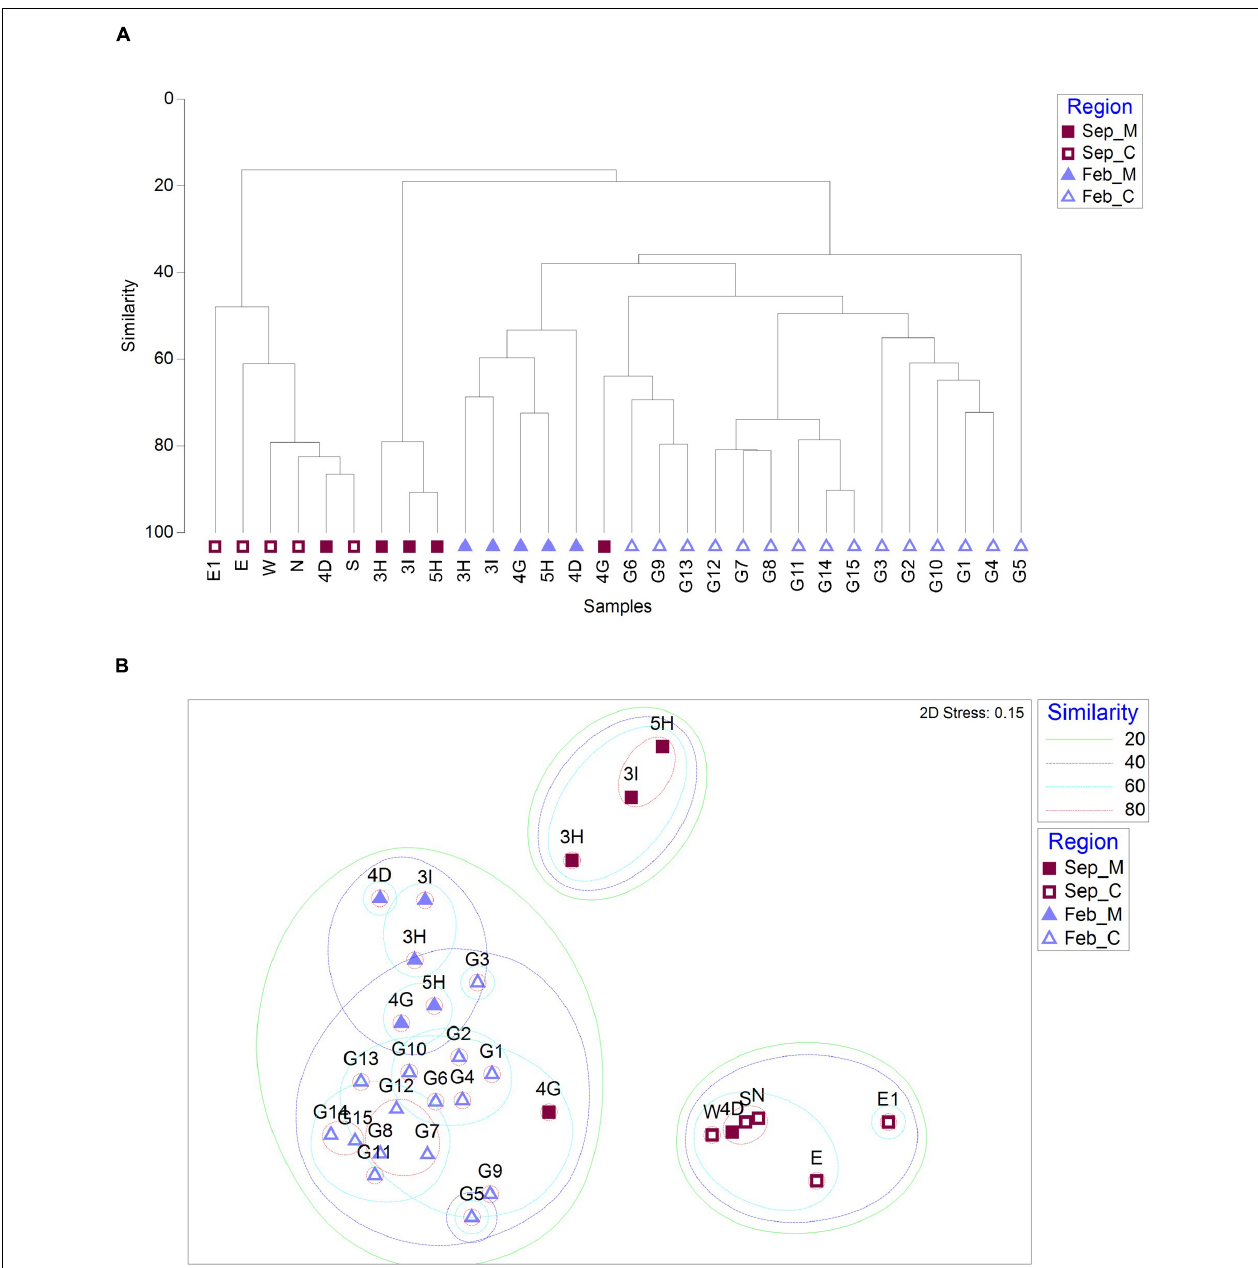
FIGURE 4 | Similarity analysis of fish assemblages between sample collection sites based on Bray–Curtis dissimilarity [ (A) dendrogram; (B) non-metric multidimensional scaling (NMDS) plot; and M and C in the legend represent aggregate mining and control regions, respectively].